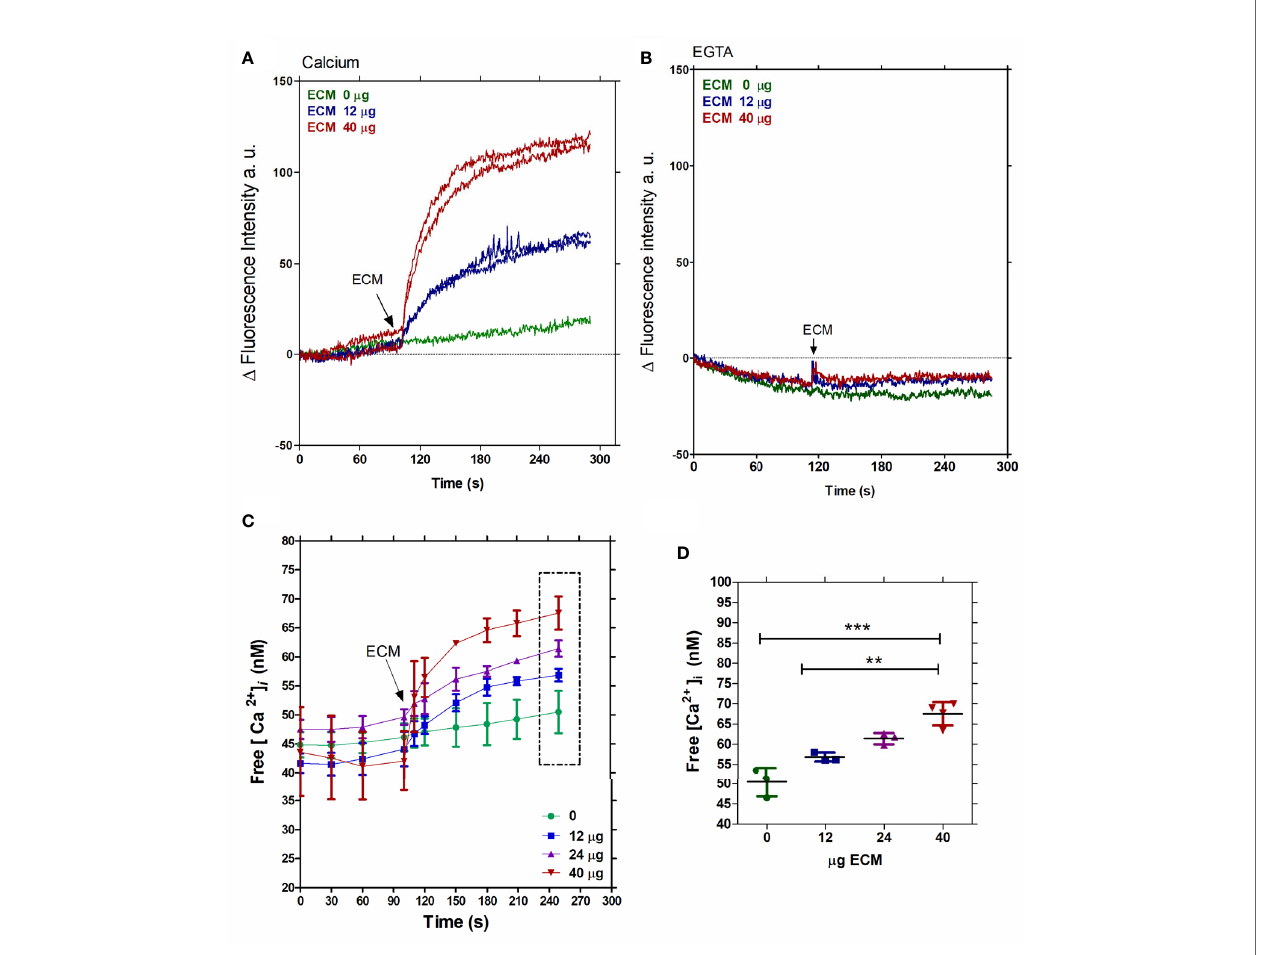
FIGURE 1 | Free intracellular calcium increases in T. cruzi trypomastigotes upon interaction with the ECM. Fluo-4-AM-loaded tissue culture-derived trypomastigotes were employed. (A) Fluorescence intensity measured in the presence of two ECM concentrations (12 or 40 µg) and 2 mM extracellular Ca 2+ . (B) Fluorescence intensity measured in the presence of two ECM concentrations (12 or 40 µg) and 1 mM EGTA. (C) Increment of free intracellular [Ca 2+ ] in response to the ECM concentrations (0, 12, 24, or 40 µg). (D) Dose-dependent free intracellular [Ca 2+ ] and ECM concentration after 2.5 min of incubation, from Figure 1C . Statistical signi fi cance was P < 0.05, Tukey test ANOVA. Figures 1A, B are representative of three independent experiments, using three different commercial samples of ECM. **P < 0. 01, ***P <